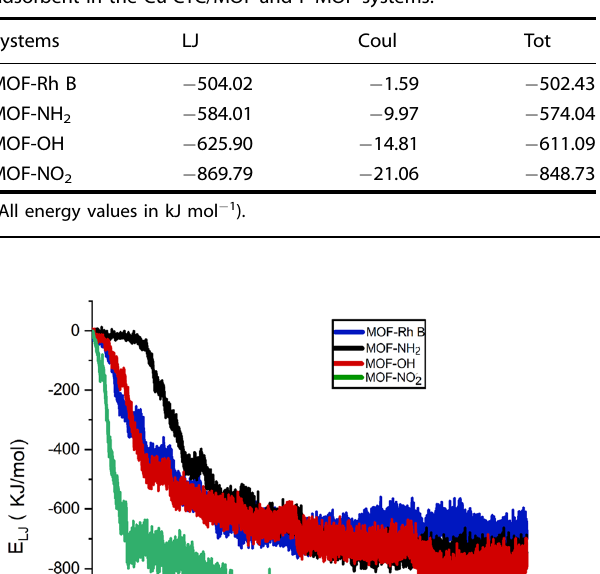
Table 1. The LJ, Coul, and Tot energies between of Rh B and adsorbent in the Cu-CTC/MOF and F-MOF systems.